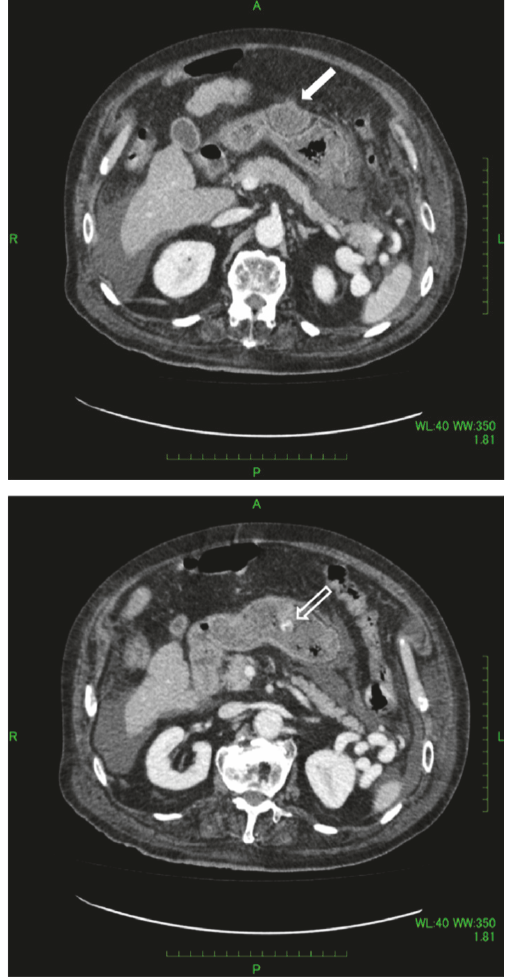
Figure 2: A contrast enhanced computed tomography scan demon- strated gastric extraluminal compression by hepatocellular car- cinoma (arrow) and extravasation of contrast medium into the stomach (open